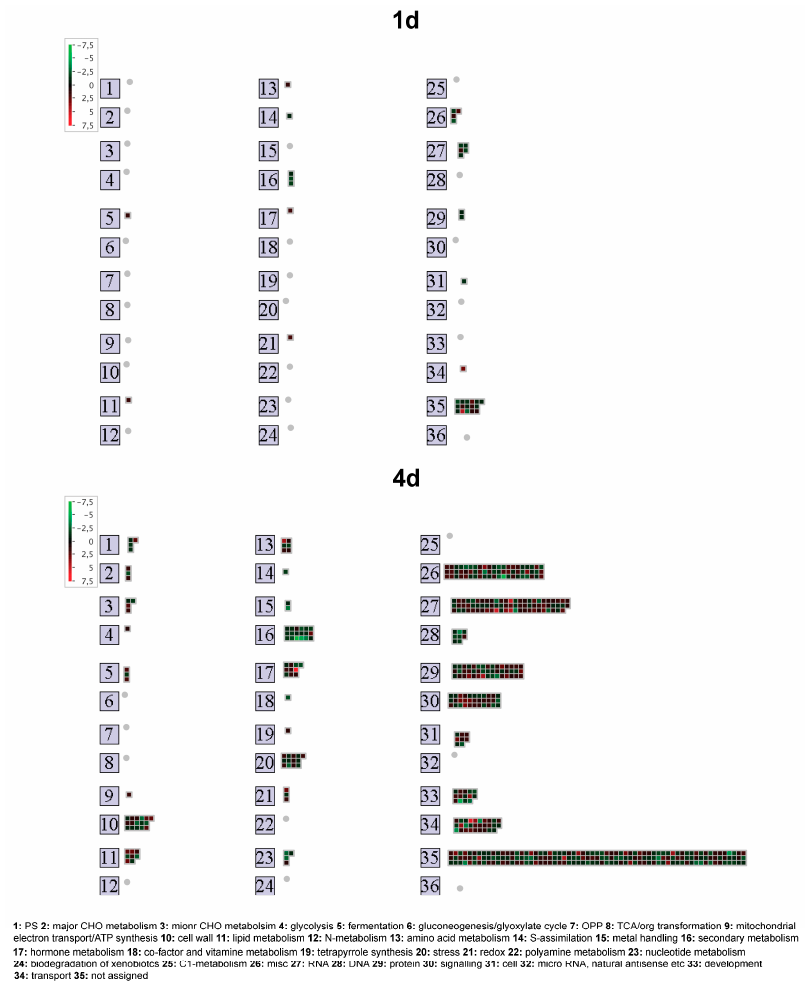
Figure 2. Overview of transcripts specifically modulated in Lo5 roots at 1 d and 4 d according to MapMan bincode classification. Log 2 (ratio) is shown by the color scale (green indicates a decrease and red an increase in transcript abundance in the comparisons 1 d vs. 0 d and 4 d vs. 0 d). Colored square: modulate transcript; gray circle: category without modulated